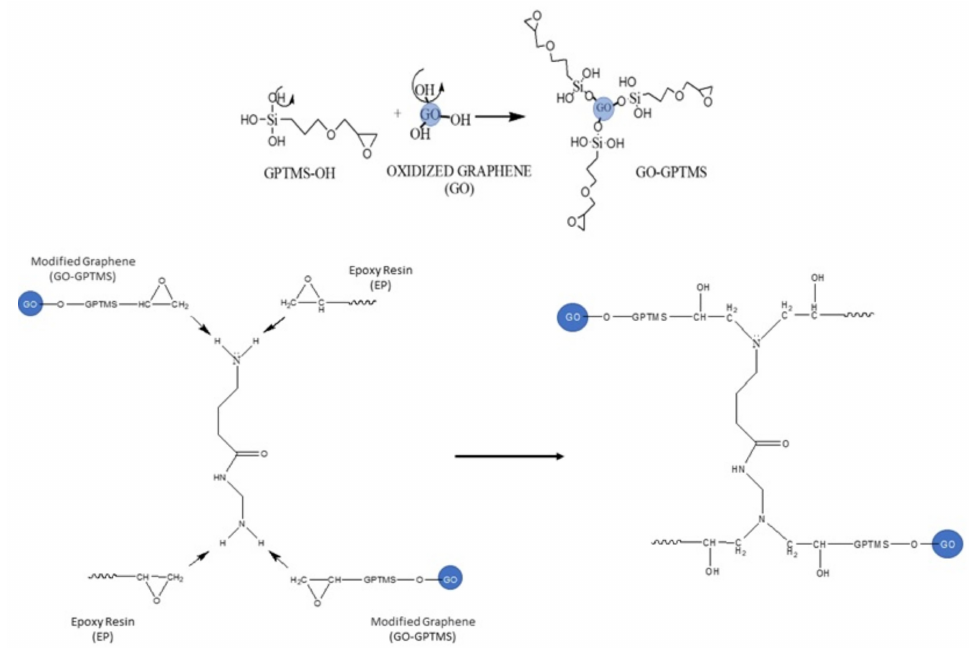
Figure 15. Schematic illustration of the GO-GPTMS/epoxy